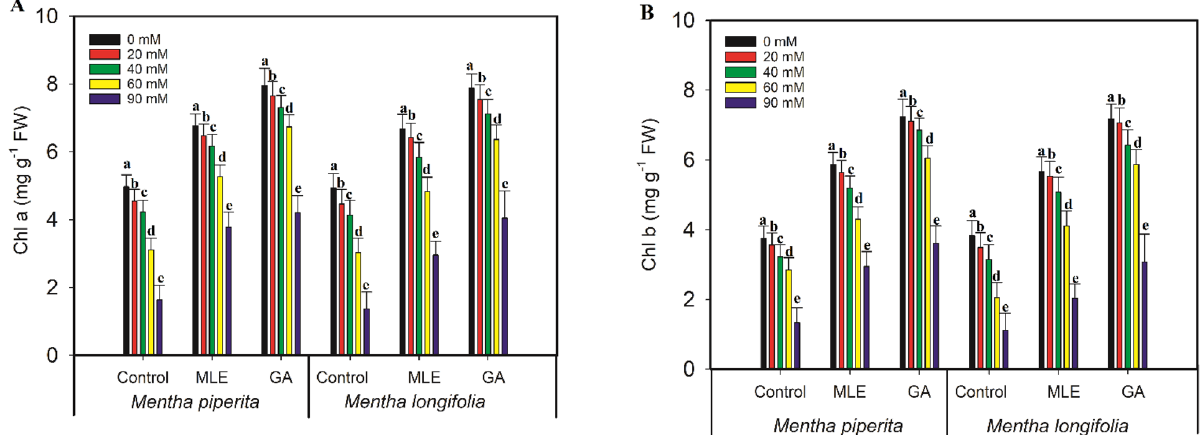
Figure 1. Effect of MLE ( Moringa oleifera ) and GA ( Ulva intestinalis ) on Chl a ( A ) and Chl b ( B ) in the Mentha species under salt stress (0 mM, 20 mM, 40 mM, 60 mM, 90 mM). The data displayed are the means (± SE) of three replicates, and bars of dissimilar letters differ significantly at the p ≤ 0.05 level.